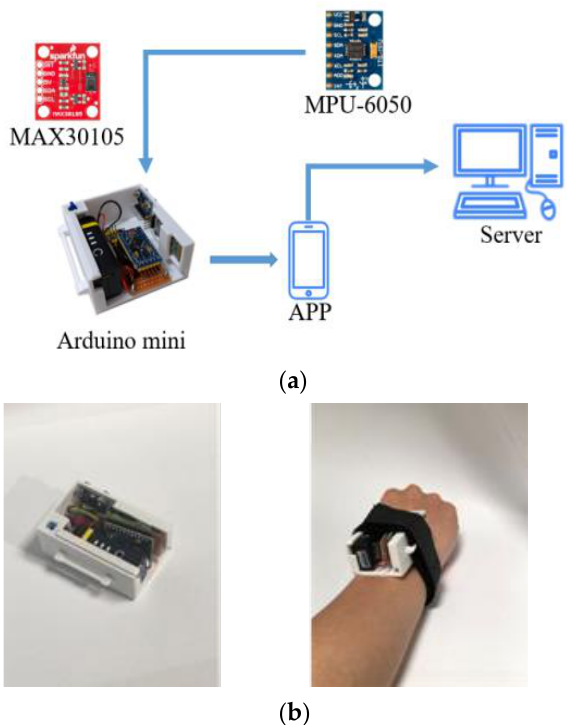
Figure 2. The components and the prototype of the system. ( a ) System implementation; ( b ) a wristband prototype.